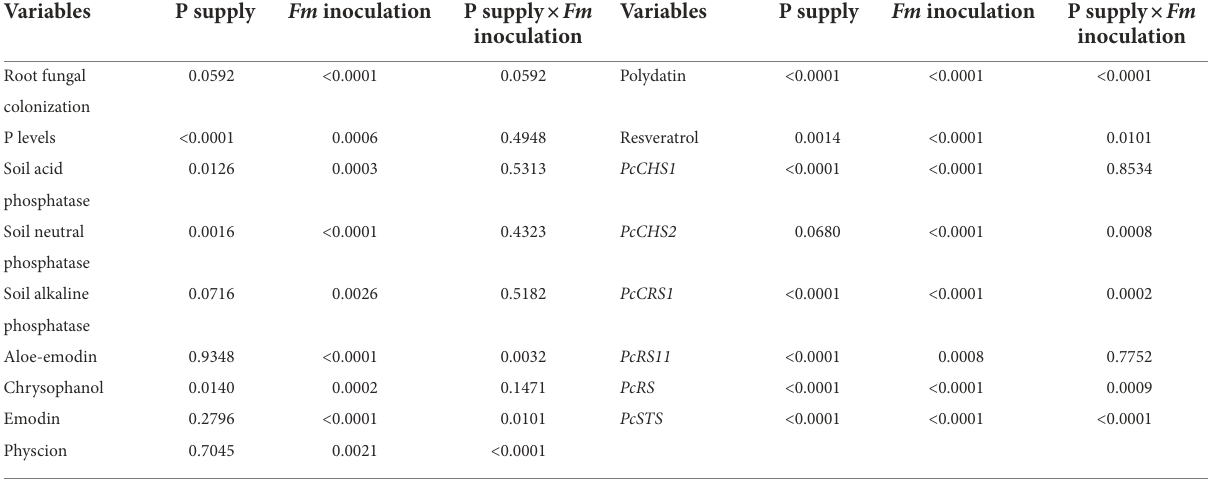
TABLE 1 Significance of variables between Funneliformis mosseae and P supply.